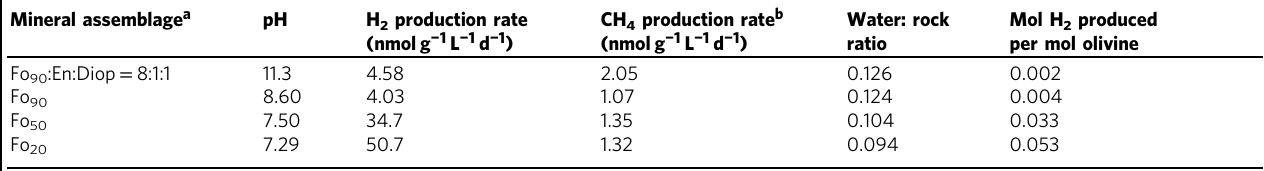
a Fo 90 = forsteritic olivine (forsterite:fayalaite = 9:1), En = enstatite, Diop = diopside, Fo 50 = (Fo:Fa = 1:1), Fo 20 = (Fo:Fa = 2:8) b CH 4 production is predicted from allowing H 2 and dissolved inorganic carbon (DIC) to equilibrate readily, while H 2 production is kinetically controlled by dissolution of primary phases